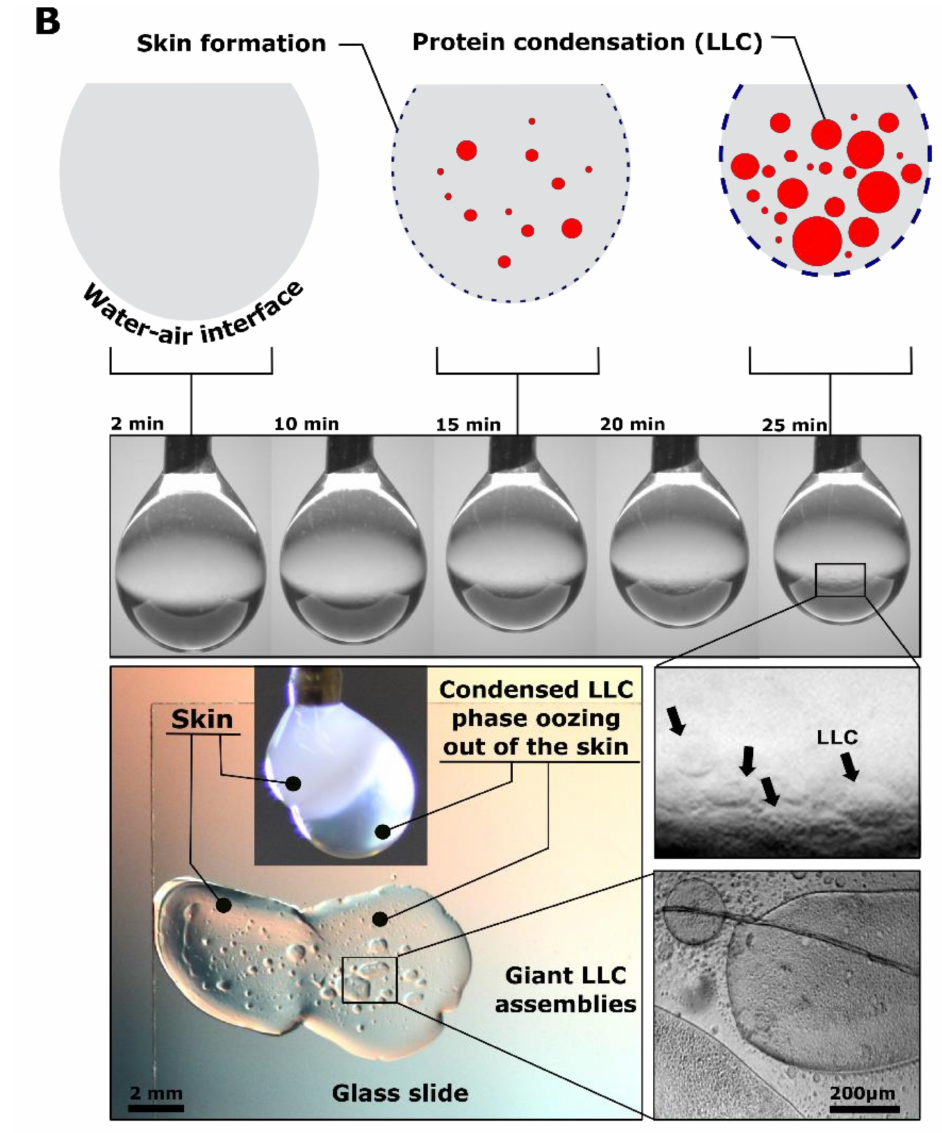
Figure 1. Structural evolution during evaporation induced self-assembly of pendant droplet of the silk-like protein. ( A ) Schematic representation of the genetically engineered and recombinantly produced spider silk-like 3-block architecture. ( B ) This results in two distinct assemblies. A highly crystalline skin at the water–air interface and liquid–liquid phase separation (coacervate forma- tion)